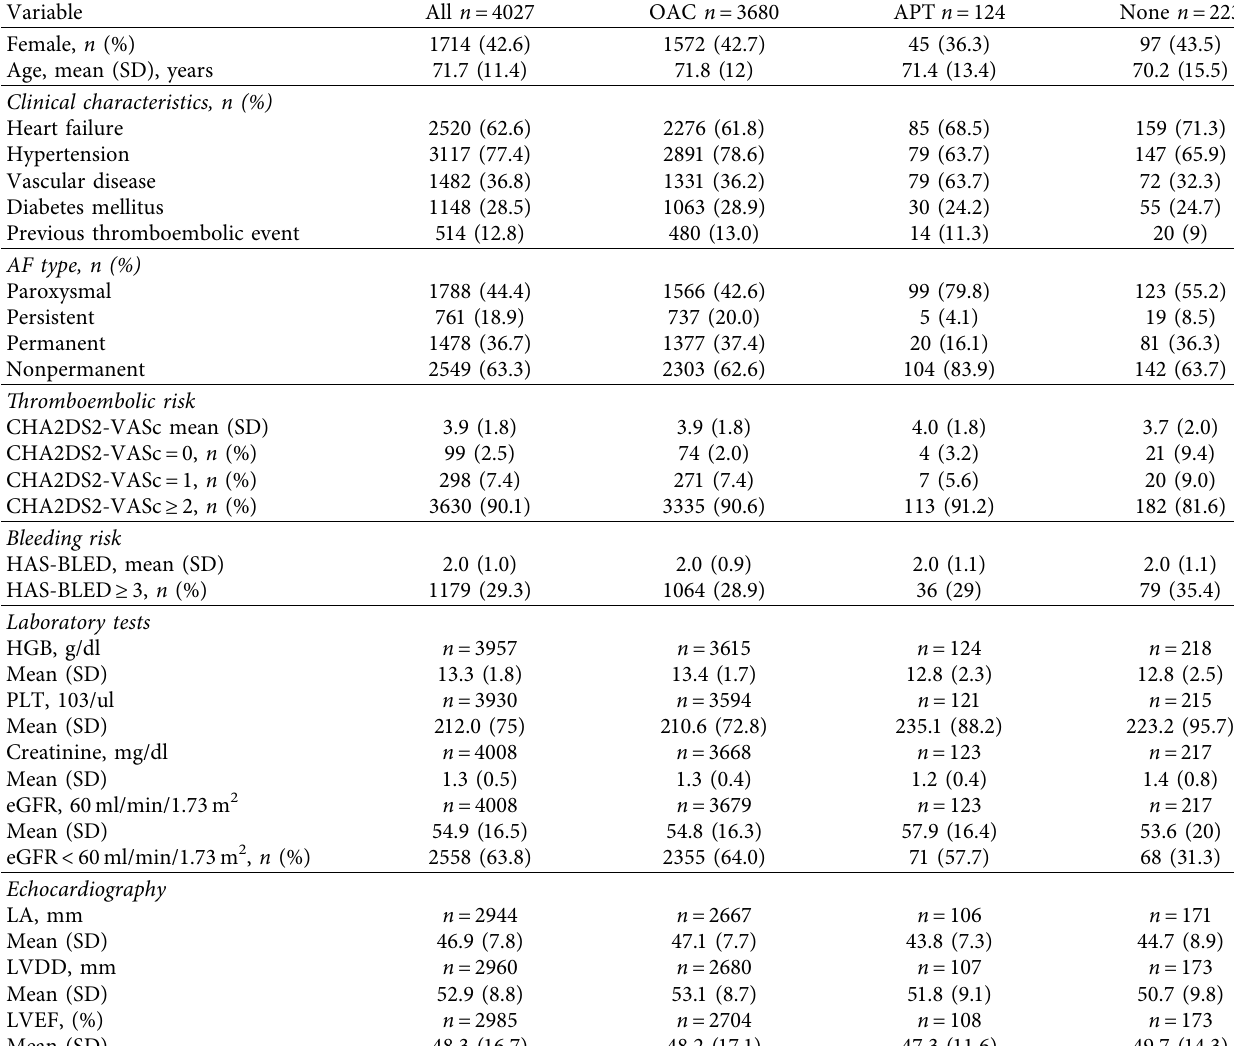
Table 1: Baseline characteristics of the study